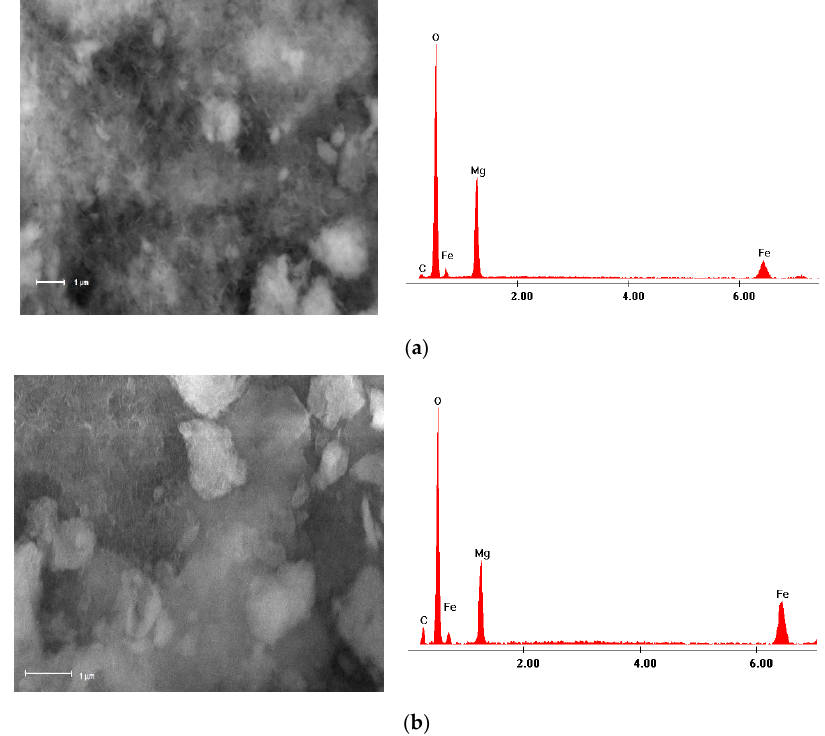
Figure 2. SEM images and X-ray dispersion analysis (EDX) spectra of the synthesized samples: ( a ) Mg 4 Fe and ( b ) Mg 4 Fe–450.